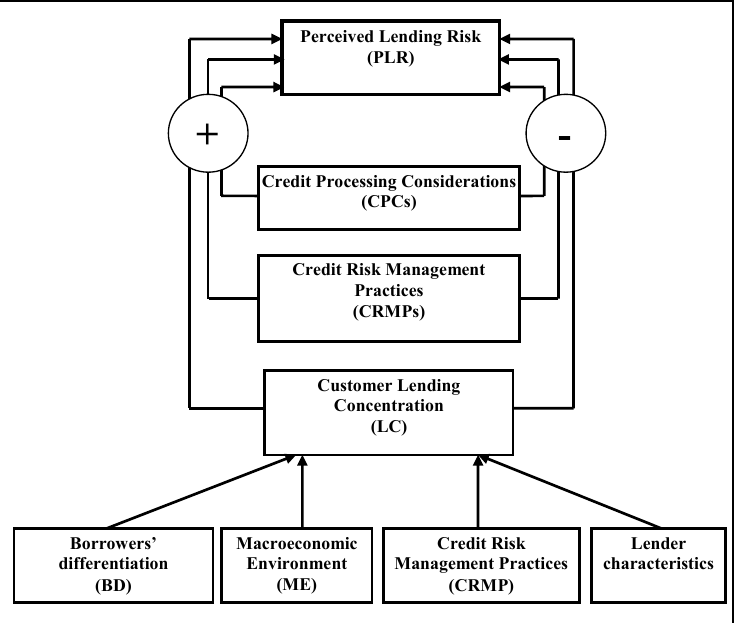
Conceptual Model of Determinants of Lenders’ Perceived Lending Risk (PLR)